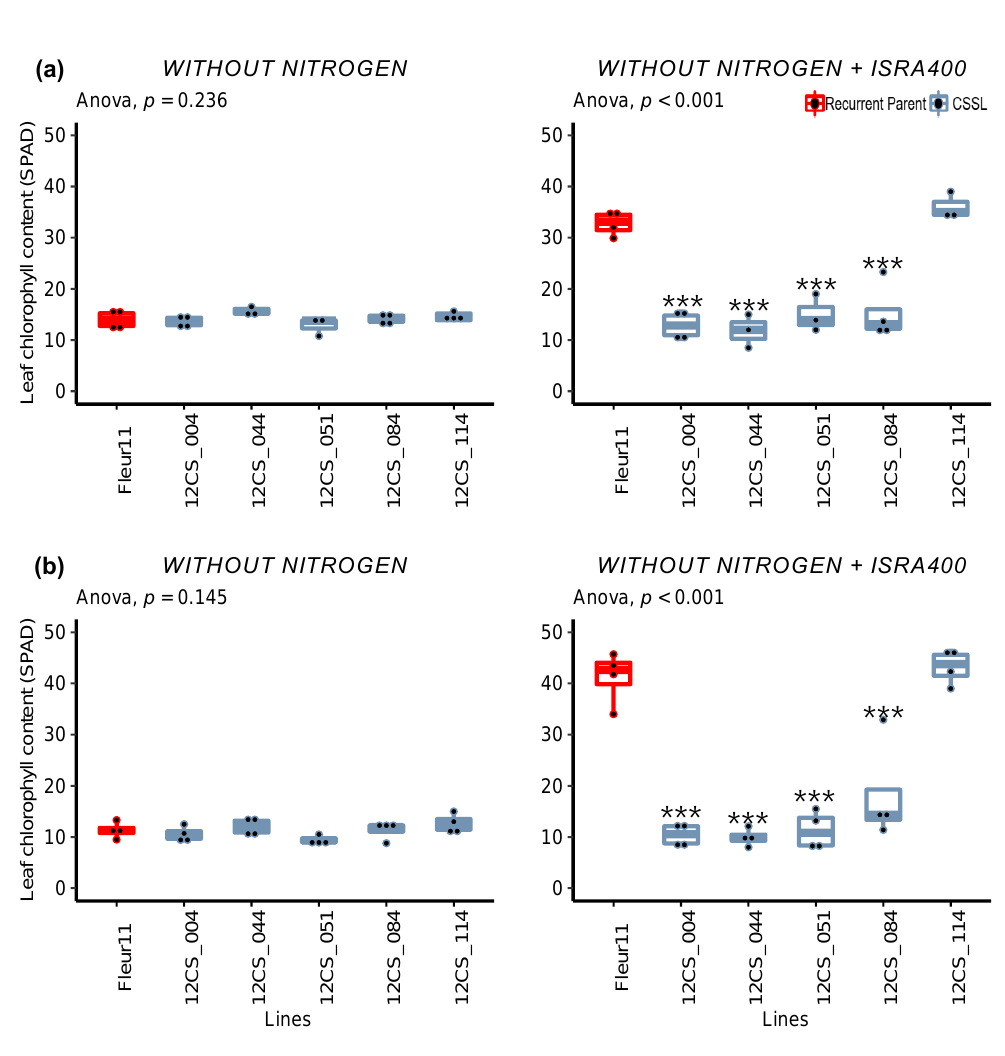
Figure 2. Variation in leaf chlorophyll content 35 days after inoculation under controlled conditions. ( a , b ): First and second experiments, respectively. Without nitrogen and without nitrogen + ISRA400 indicate uninoculated plants (negative control) and plants inoculated with B. vignae ISRA400, respectively. *** indicate values significant at p < 0.001, respectively, using Dunnett’s multiple comparisons test.